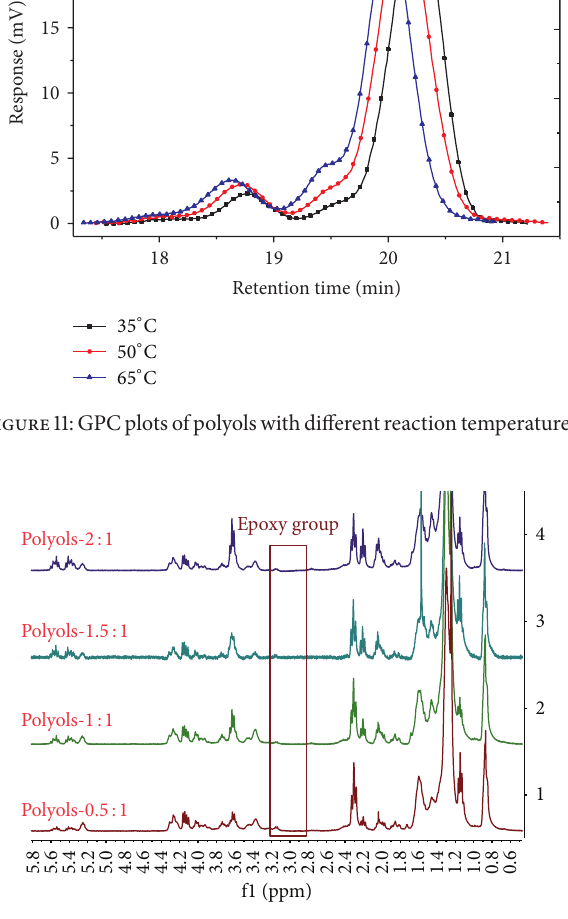
Figure 12: 1 H-NMR spectrum of polyols with different ratios between COD and ESBO.